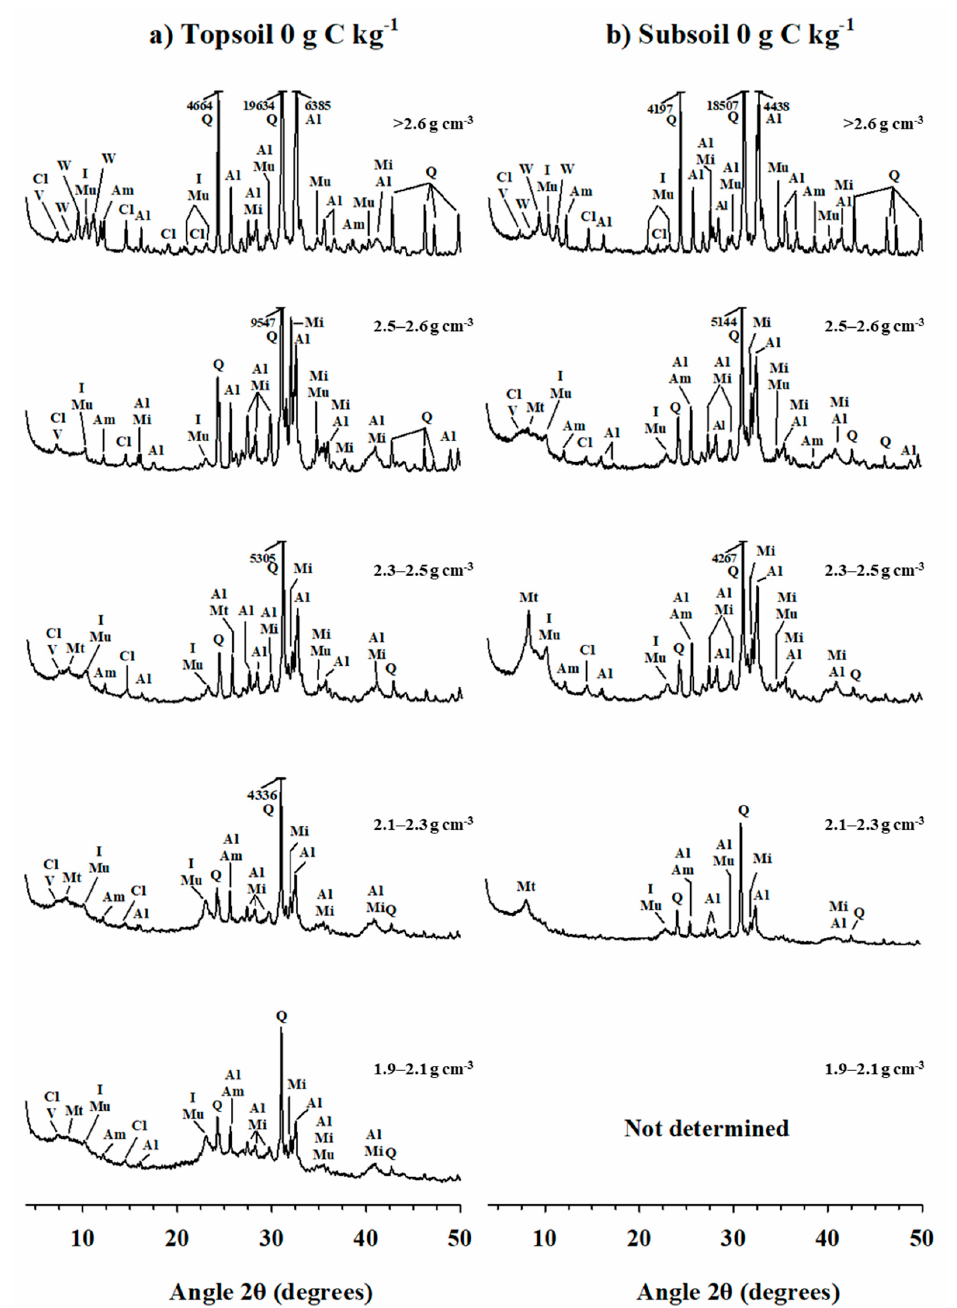
Figure 2. X-ray diffractograms (Co-K α radiation) of soil density fractions in ( a ) topsoil and ( b ) subsoil that were incubated without residue. Mineralogical analysis of the subsoil 1.9–2.1 fraction is missing due to insufficient mass to analyze this fraction. All diffractograms are presented on the same vertical scale (intensity) and were truncated for legibility when the reading exceeded 4000 counts. The maximum number of counts is written next to the peak (Al, albite; Am, amphibole; Cl, chlorite; I, illite; Mi, microcline; Mu, muscovite; Mt, montmorillonite; Q, quartz; V, vermiculite; W, sodium